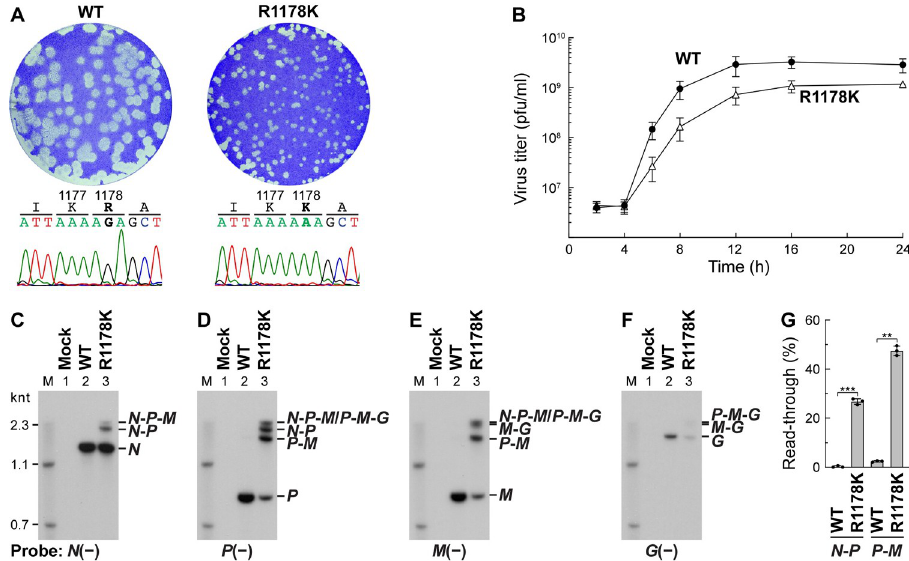
Fig 6. Recombinant VSV with the R1178K mutation in the L gene produces polycistronic mRNAs in infected cells. ( A ) Recombinant (r) VSV with the R1178K mutation was generated from cDNA and its plaque phenotype (right) was compared with that of WT rVSV (left). Nucleotide sequences of the mutation sites in genomes of plaque- purified rVSVs are shown with their corresponding amino acid sequences. ( B ) Single-step growth curve experiments were performed by infecting BHK-21 cells with rVSV harboring the WT (closed circles) or R1178K (open triangles) L gene at a multiplicity of infection of 5. Virus titers are expressed as plaque-forming unit (pfu) per ml. Symbols and error bars represent the means of titers and standard deviations, respectively (n = 3). ( C–F ) Total RNAs were extracted from mock-, WT rVSV-, or R1178K mutant rVSV-infected cells at 9-h post-infection and treated with RNase H in the presence of oligo(dT). The RNase H-treated RNAs (mock, 0.1 μ g; WT, 0.1 μ g; R1178K, 0.01 μ g) were analyzed by Northern blotting using the indicated probes as described in Fig 5. ( G ) Percentages of read-through at the N - P and P - M junctions were calculated as in Fig 5E. Statistical significance was determined by Student’s t test [ns, not significant (p � 0.05); � , p < 0.05; �� , p < 0.01; ��� , p < 0.001; ���� , p < 0.0001; compared to control